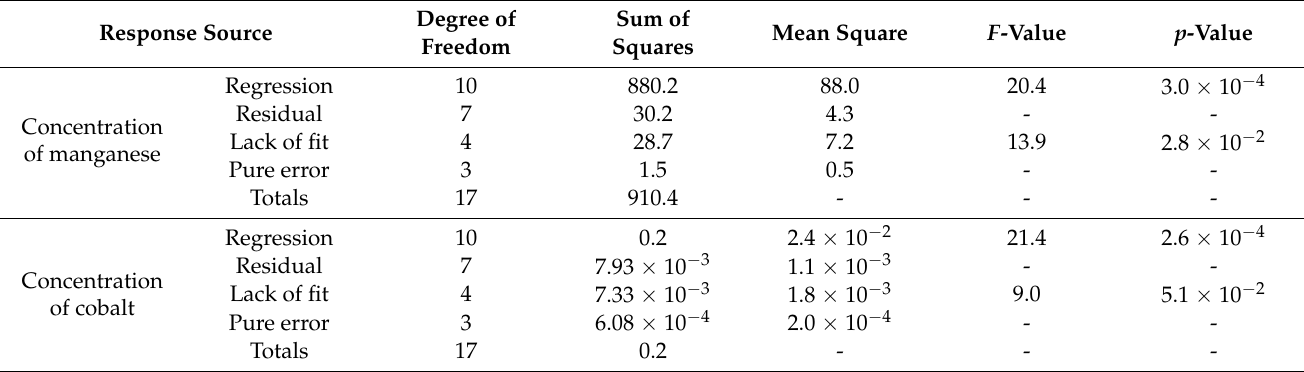
Table 7. Results of the analysis of variance of the fitted models for the stripping of manganese and cobalt. Response Source